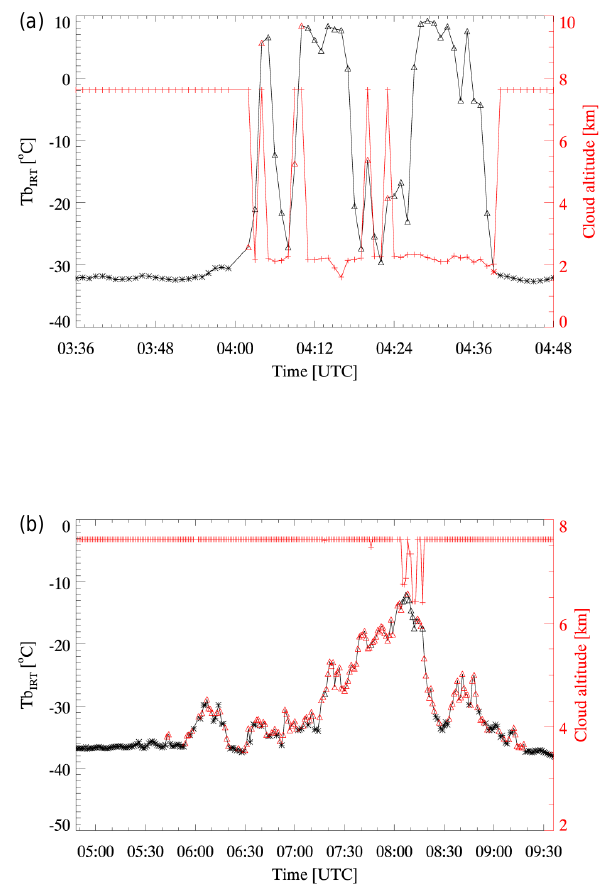
Figure 12. Two representative cases for characterization of the com- parison of cloud detection and cloud-base altitude (red crosses) be- tween IRT and ceilometer. The red symbols indicate the discrepancy cases (stars and triangles represent misses and false alarms, respec- tively). On the other hand, the black stars and triangles represent the successful cases. Panel (a) represents the highly variable sky condi- tions on 2 October 2012 and (b) exemplifies the uniform high-cloud conditions obtained on 28 March